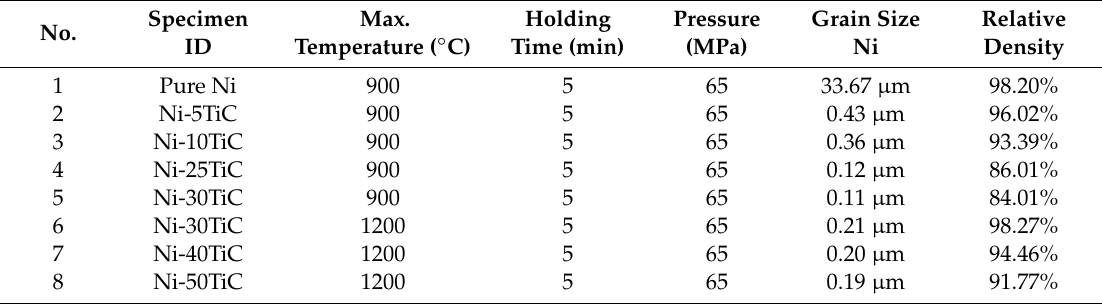
Table 1. SPS parameters, grain size, and relative density of nickel for Pure Ni, Ni-5TiC, Ni-10TiC, Ni-25TiC, Ni-30TiC, Ni-40TiC, and Ni-50TiC